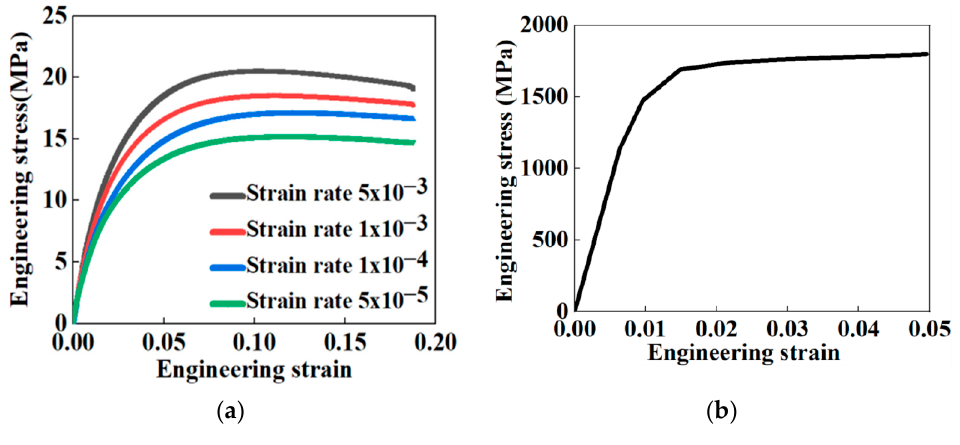
Figure 3. Uniaxial tensile test results: ( a ) HDPE; ( b ) steel wire.